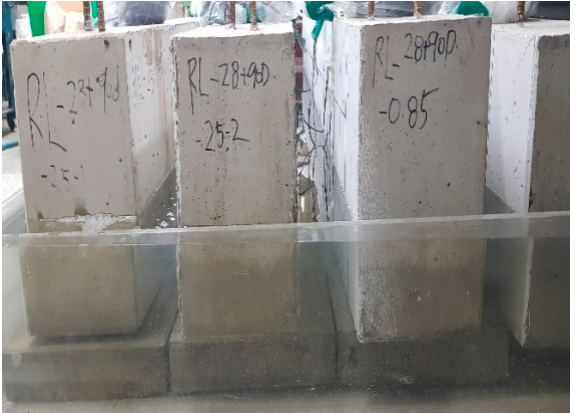
Figure 7. Partial water curing of pre-damaged test members.